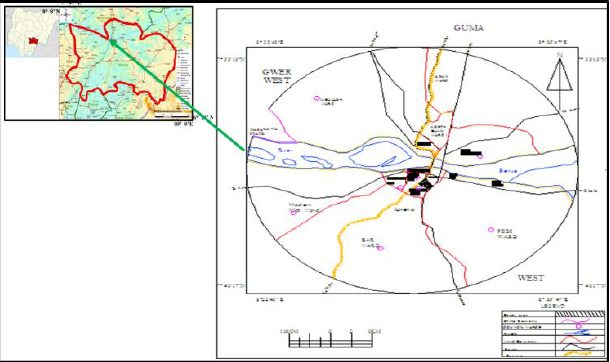
Figure 1. Makurdi LGA, the study